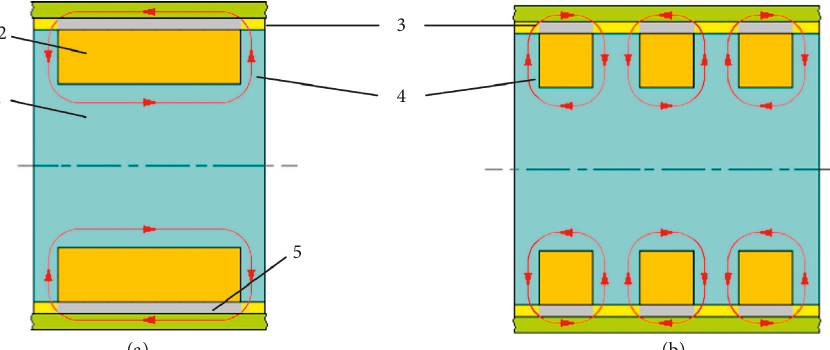
Figure 4: Difference of use between (a) single coil and (b) multiple coils with alternating polarity: 1, valve core; 2, coil; 3, activation area; 4, magnetic flux; 5, nonmagnetic section [35, 47, 48].